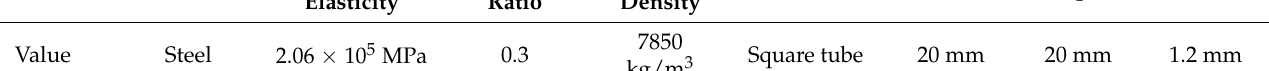
Figure 7. A steel truss structure.